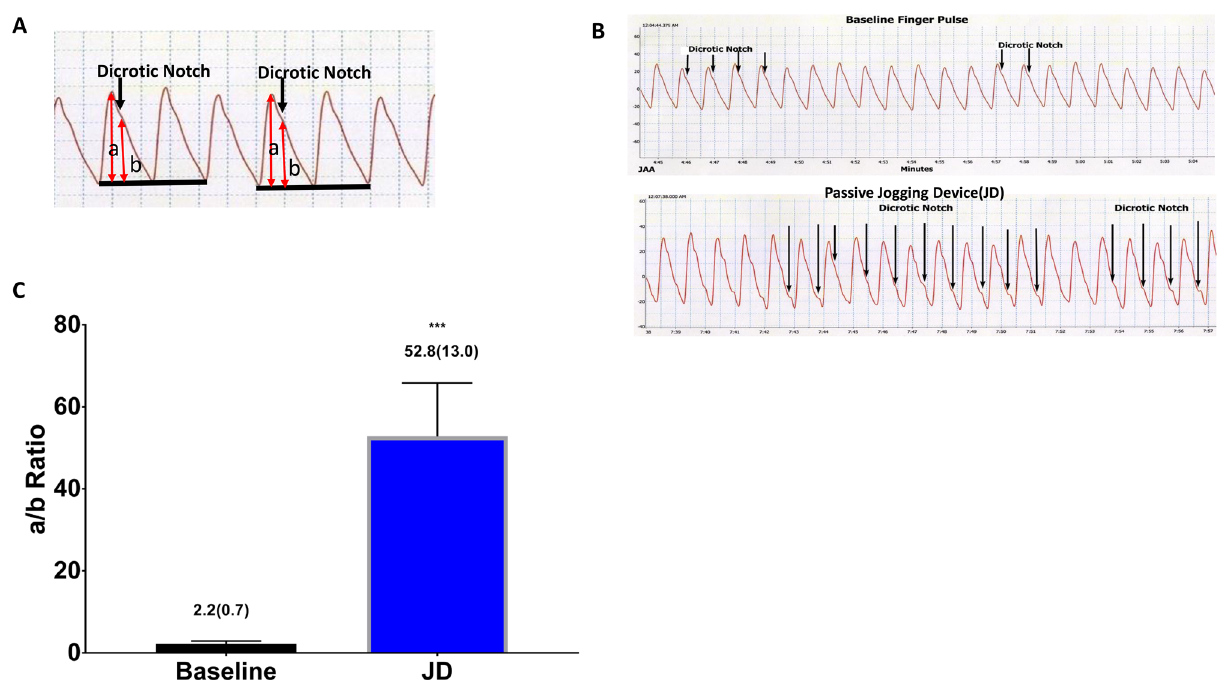
Figure 4. Passive Jogging Device (JD) increases Nitric Oxide (NO) Bioavailability. ( A ) Representative Plethysmographic arterial pulse waveform at baseline denoting the position of the dicrotic notch and the a and b position on the pulse waveform. ( B ) representative tracings of one subjects descent of the dicrotic notch at baseline and during use of JD device ( C ) JD in seated posture increased a/b ratio 24-fold from baseline values, confirming that JD increases NO bioavailability in human subjects. (***p < 0.001 Baseline vs. JD) [MEAN